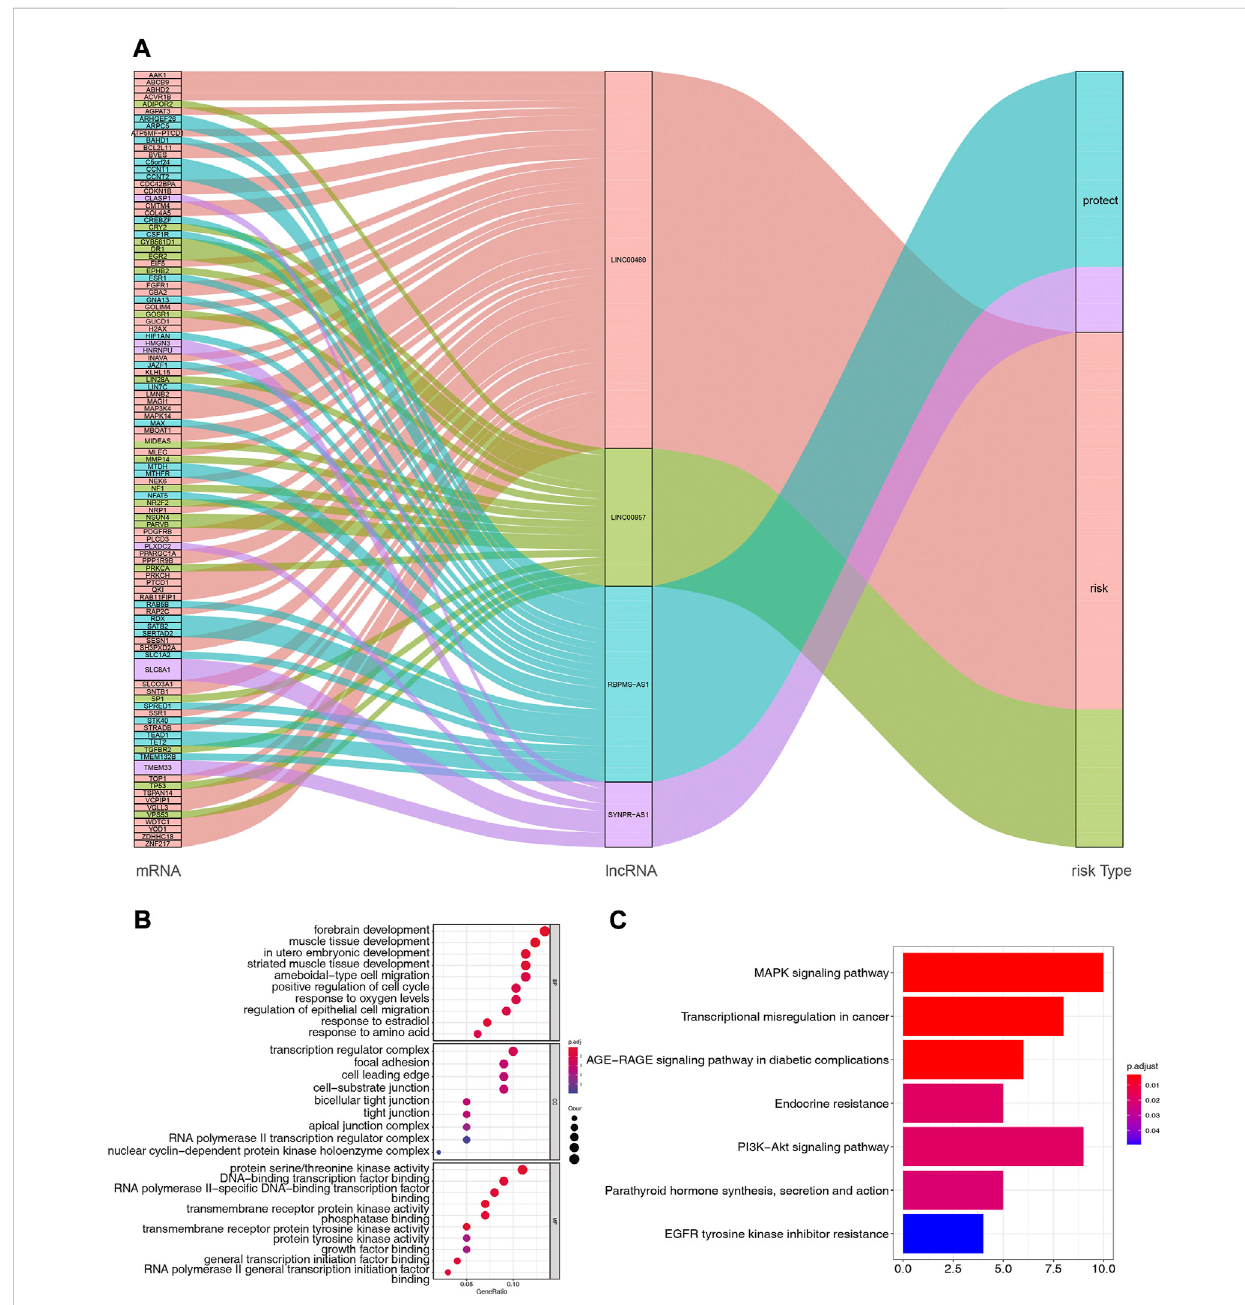
FIGURE 8 (A) Correspondenceof103mRNAsregulatedbyceRNAnetworkwith4prognosticlncRNAs. (B) Functionalenrichmentanalysisof103mRNAsinthe ceRNAnetwork,thegraphrepresentsGO-BP,GO-CCandGO-MFtermsfromtoptobottom,respectively. (C) Pathwayenrichmentanalysis ofmRNAsin the ceRNA network (7 enriched pathways are